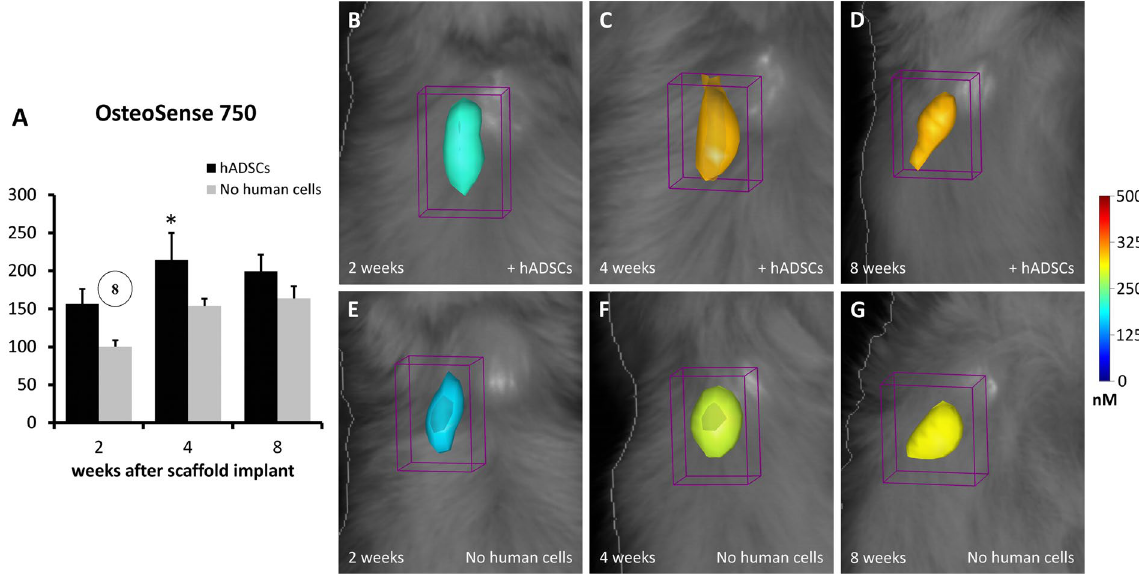
Figure 3. FMT images and in vivo quantification of osteogenesis within the implanted scaffolds. The color scale indicates the mean fluorescent probe concentrations within the ROI, and the graph ( A ) shows the mean values of probe content (in pmol) calculated within groups and reported as percent of the mean value of the 2 wk group with cell-free scaffold. It is evident that a higher concentration of probe (OsteoSense 750) is present when the scaffolds contain hADSCs, at all time-points ( B – D ) when compared with cell-free scaffolds ( E – G ). In the graph A, the number into the circle indicates significant difference (P < 0.05) from the corresponding time-point, in weeks (same treatment group). The asterisk indicates significant difference (P < 0.05) from the other treatment group (same